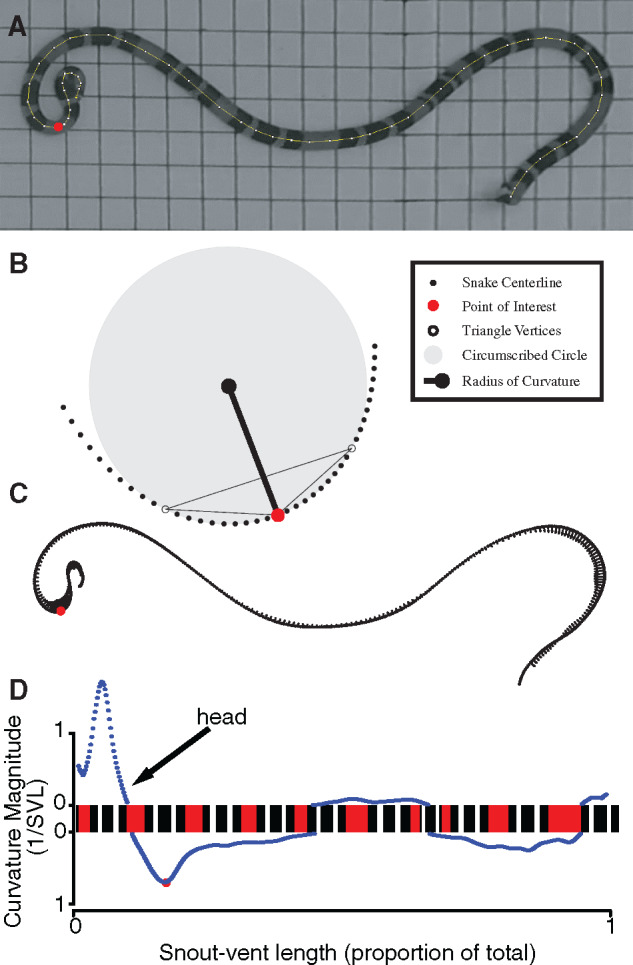
Methods for calculating the curvature of a snake. (A) Undistorted and rectified video frames at the conclusion of each bout of thrashing were traced by hand in ImageJ. (B) For each focal point in the snake centerline, the red focal point in B corresponds to the red focal point in B, the curvature was calculated as the distance from the point to a line connecting the 10th points on the left and right. (C) Curvature vectors are shown along each sampled point of the snake centerline as arrows. (D) The corresponding curvature magnitudes plotted to the right and left of a straightened depiction of a coral snake. The color pattern of the coral snake reflects the observed color pattern of this individual.